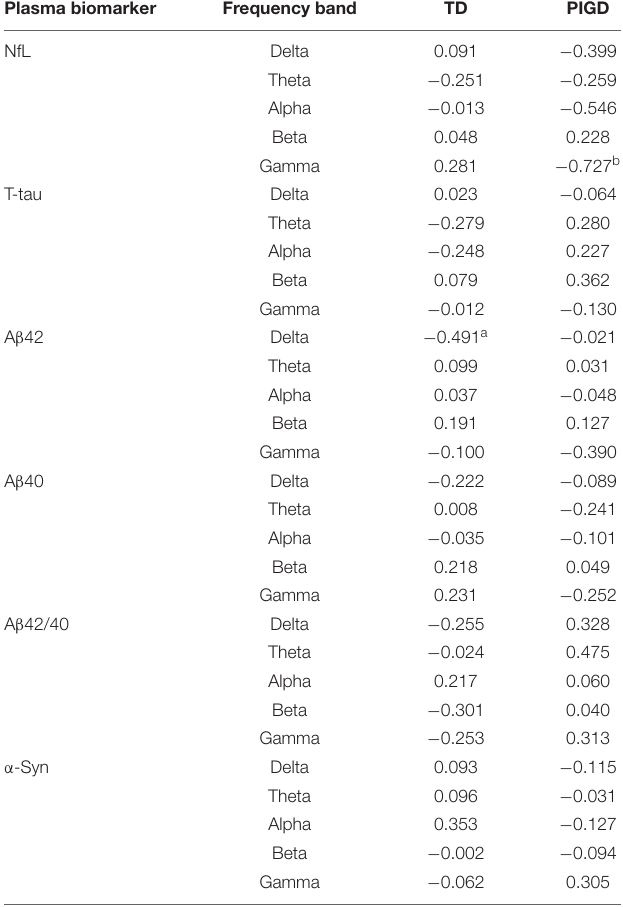
TABLE 5 | Correlation between plasma biomarkers and RR . Plasma